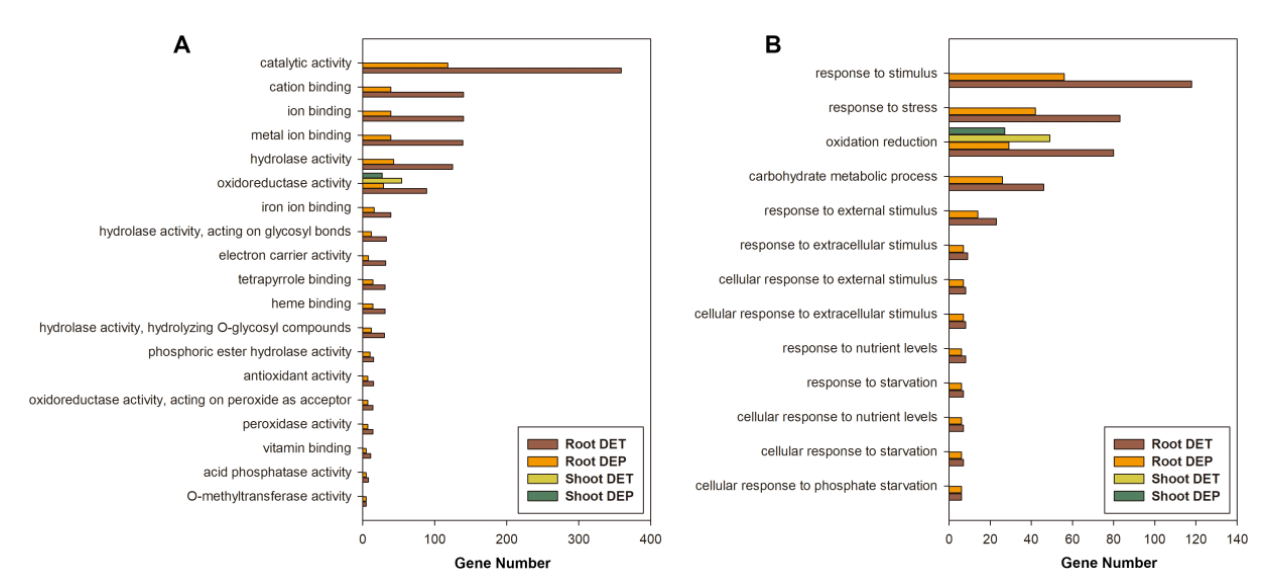
Figure 3. GO terms enrichment comparison between DETs and DEPs. GO enrichment analysis of DETs and DEPs and displayed on Molecular function ( A ) and biological process ( B ).